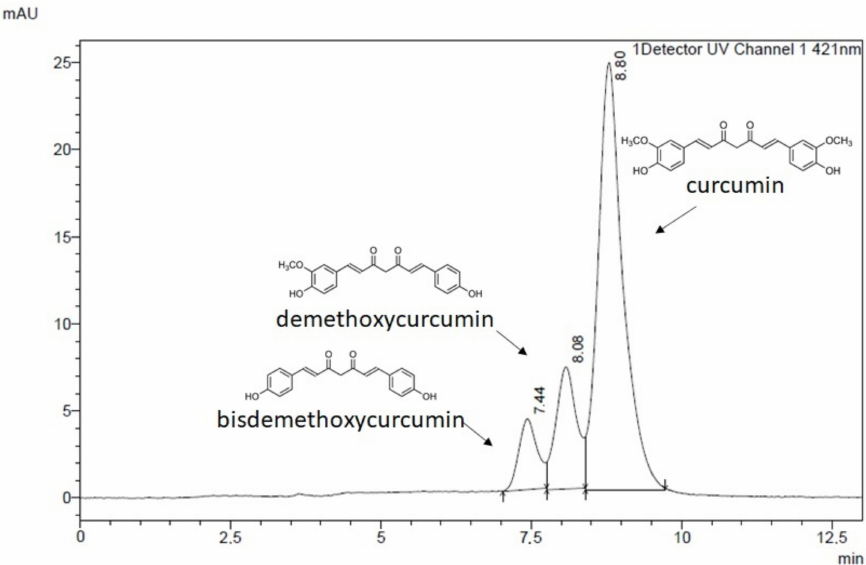
Figure 1. Chromatogram of curcuminoids from Curcuma longa sample showing abundance of curcumin and presence of demethoxy- and